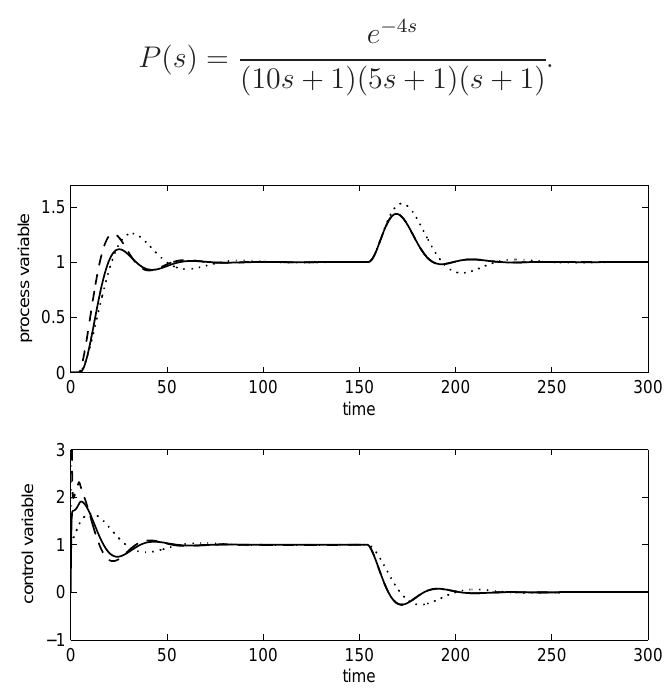
Figure 8. Results of the illustrative example for disturbance rejection performance assessment. Dotted line: initial tuning; dashed line: simple PID retuned; solid line: retuned PID plus set-point